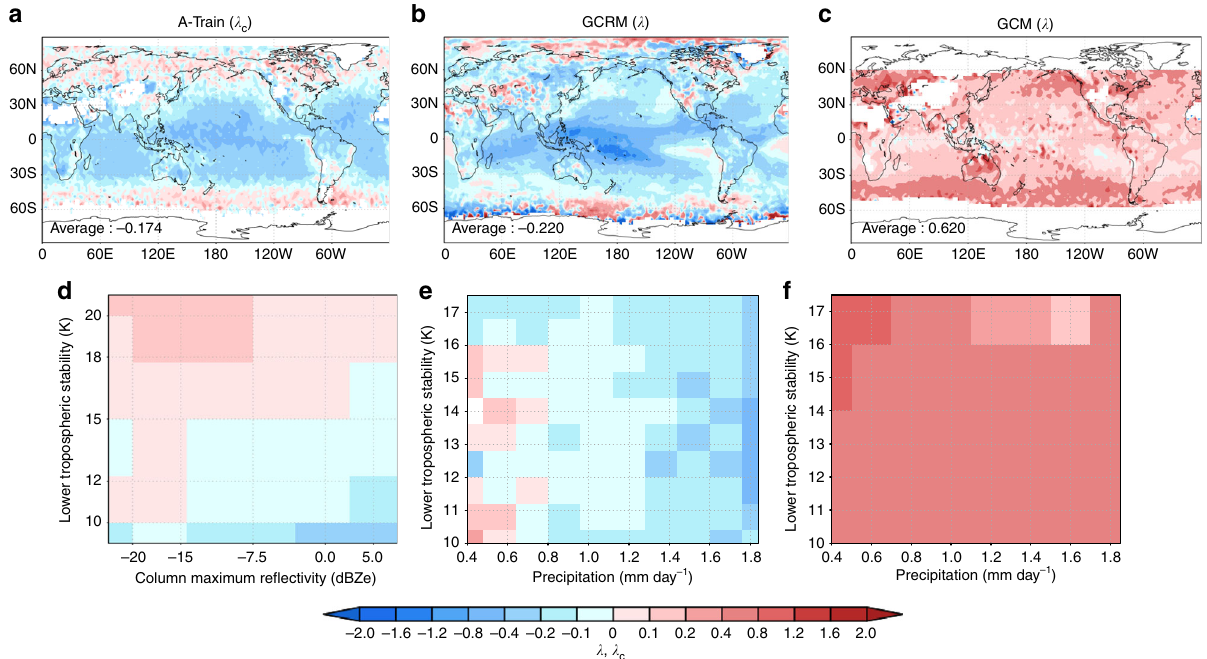
Fig. 1 Comparison of the response of the liquid water path to the perturbation of the aerosol number concentration estimated from satellite observations and the models. Geographical distribution of a λ c and b , c λ , and distribution of d λ c and e , f λ over the precipitation-lower tropospheric stability (LTS) plane estimated from the results of a , d the A-Train satellite, b , e the GCRM, and c , f the GCM 16 . Positive and negative values of λ mean an increase or decrease in LWP with increasing aerosol loading, respectively. For d – f , the results over the ocean between 60 o S to 60 o N were used. λ in each grid was calculated by the least-square method. The number written at the bottom left of a – c was the value of λ c and λ averaged from 60 o S to 60 o N. The negative value of average λ was successfully reproduced in the GCRM. Figures were mapped using the Grid Analysis and Display System (GrADS) 44 version